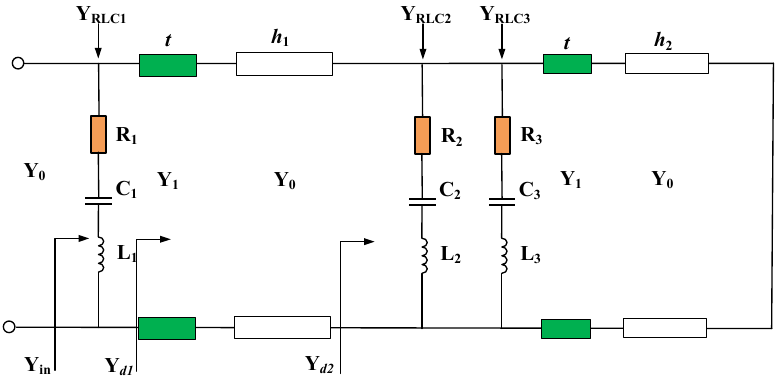
Figure 2. Equivalent circuit model of the proposed absorber unit.